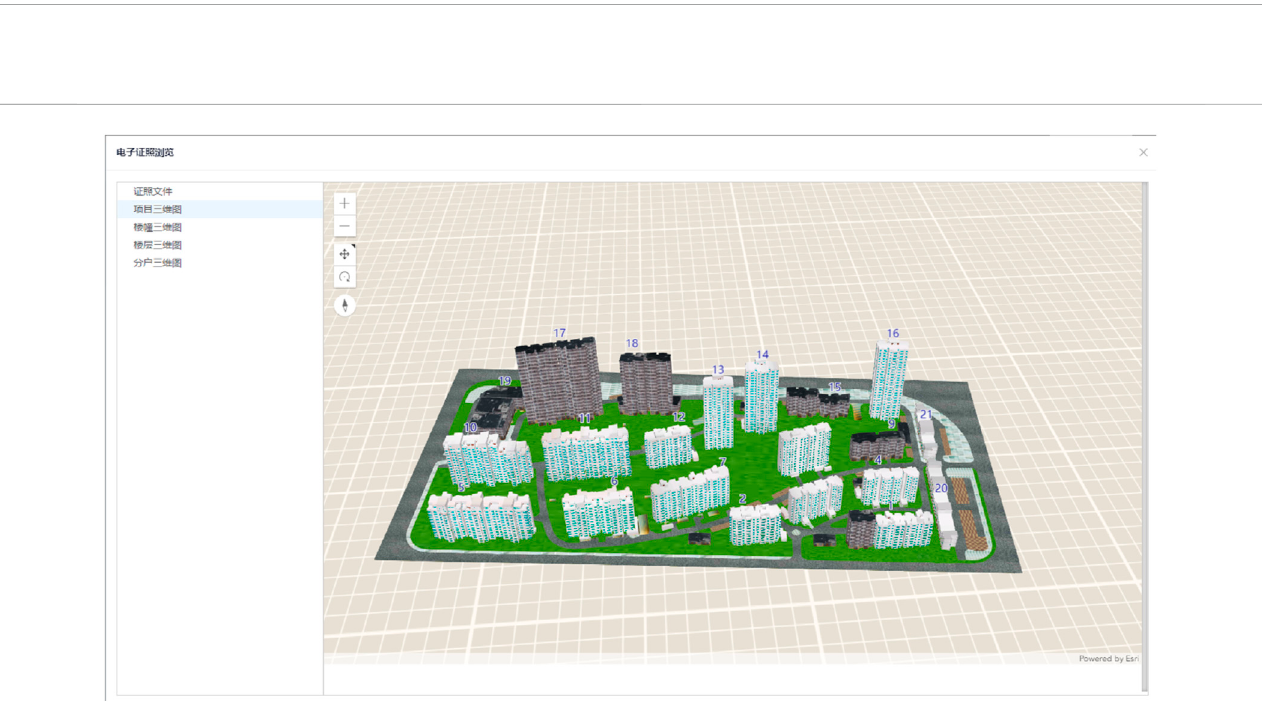
FIGURE 9 Schematic diagram of the experimental plot for the research results of integrated modeling of physical entity and legal entity of real estate registration object.